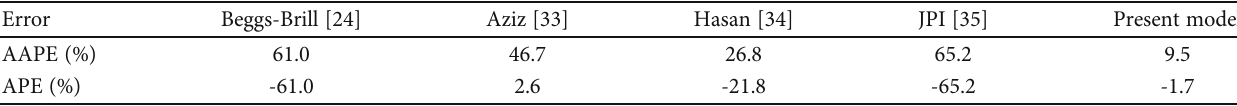
Figure 8: Measured data vs. predicted of di ff erent models (total pressure drop). Table 4: Pressure drop errors of di ff erent